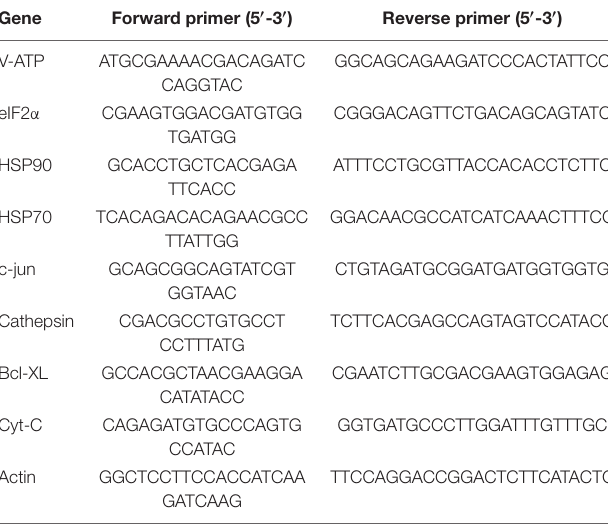
TABLE 2 | Genes and primer sequences used in gene expression validation experiments. Gene Forward primer (5 (cid:48) -3 (cid:48) ) Reverse primer (5 (cid:48) -3 (cid:48)